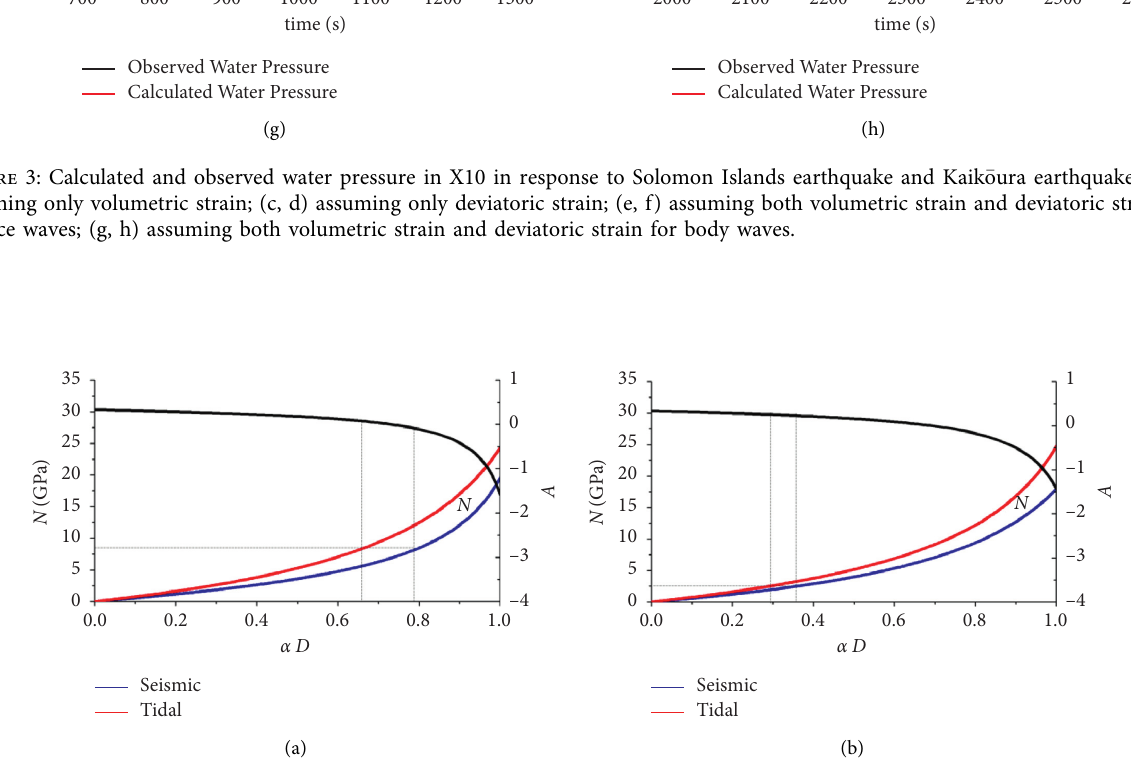
D ) for the seismic and tidal analysis. (a) Solomon Islands